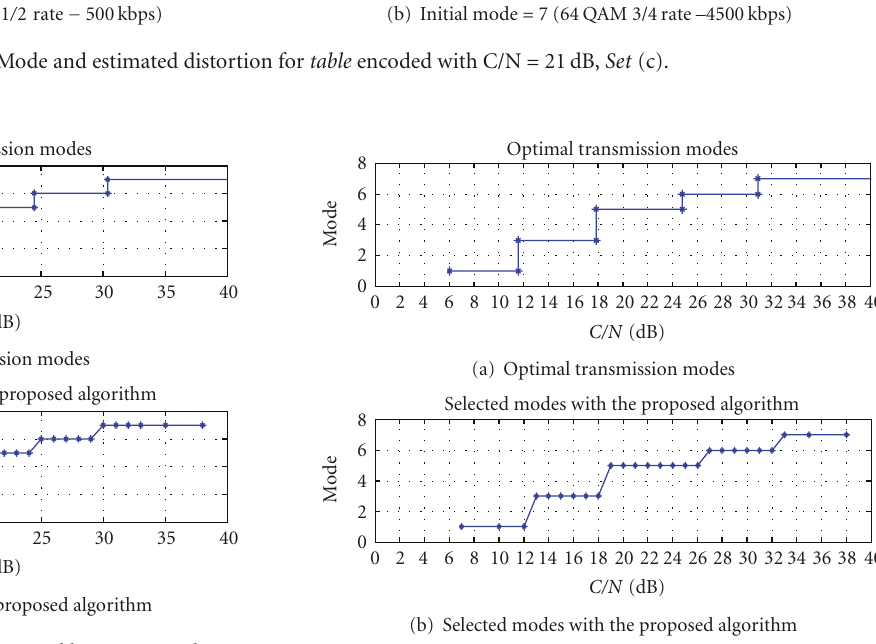
Figure 20: Mode selection comparison, akiyo , GOP number 9, initial mode = 6, Set